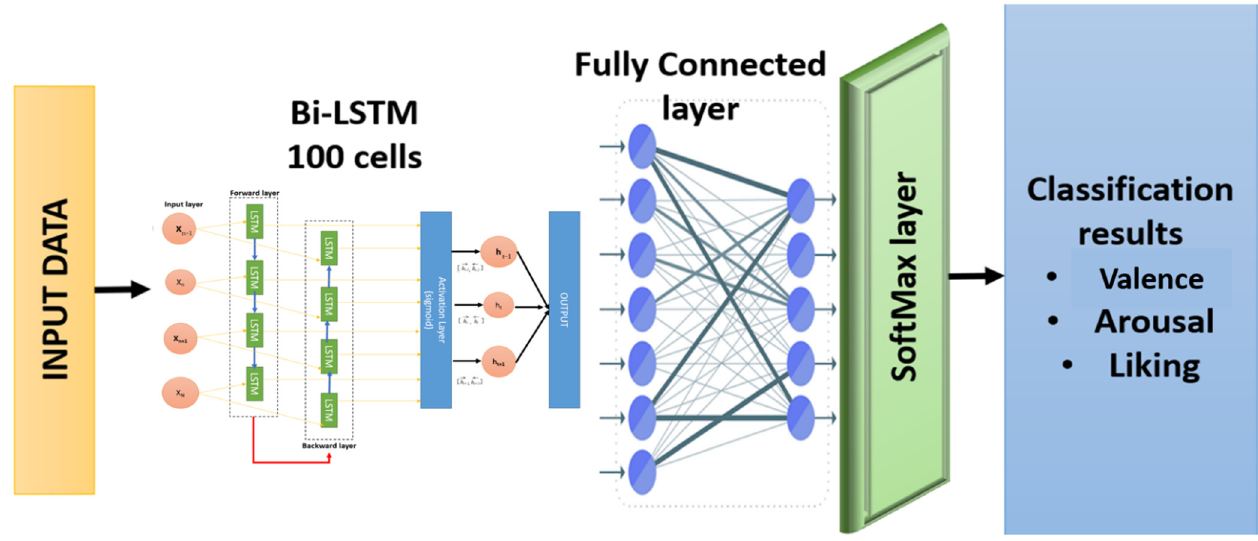
Figure 8. The main training layers.